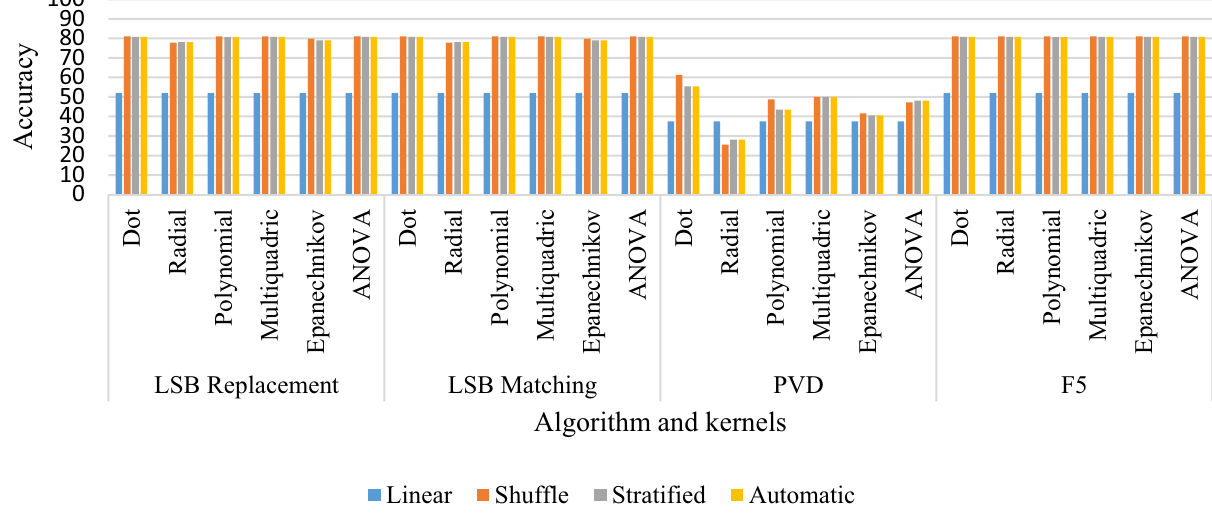
Graph 2. Result of classification of calibrated images using SVM for random %.